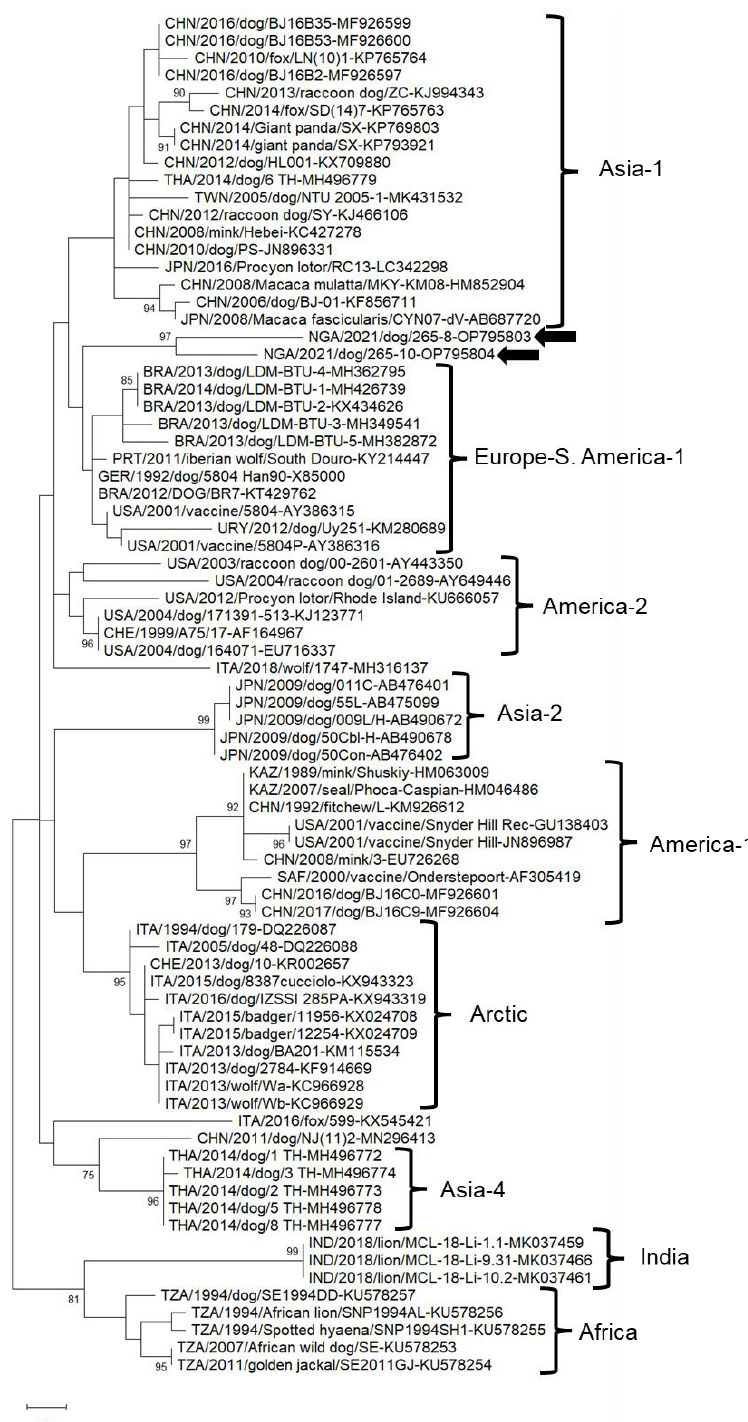
Figure 3. Phylogenetic tree based on the partial replicase sequence (307 nt) of dog circovirus (CV). The maximum-likelihood method and Kimura model (two parameters) with a gamma distribution and invariant sites were used for the phylogeny. A total of 1000 bootstrap replicates were used to estimate the robustness of the individual nodes on the phylogenetic tree. Bootstrap values greater than 75% were indicated. Black arrows indicate CV strains detected in this study and numerals in- dicate clades. Numbers of nucleotide substitutions are indicated by the scale bar.